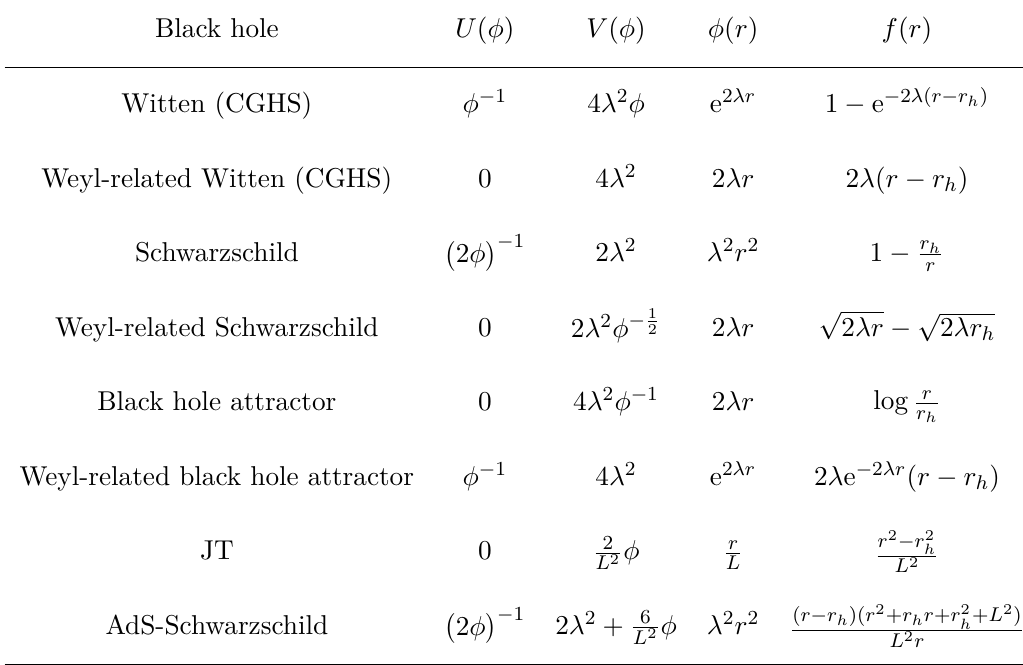
Table 2. Serval eternal black hole solutions in two-dimensional